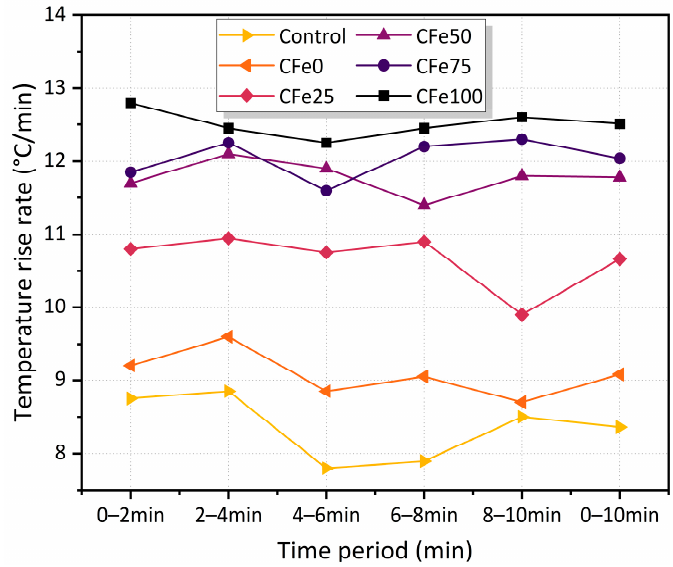
Figure 13. Change in microwave heating rate with heating